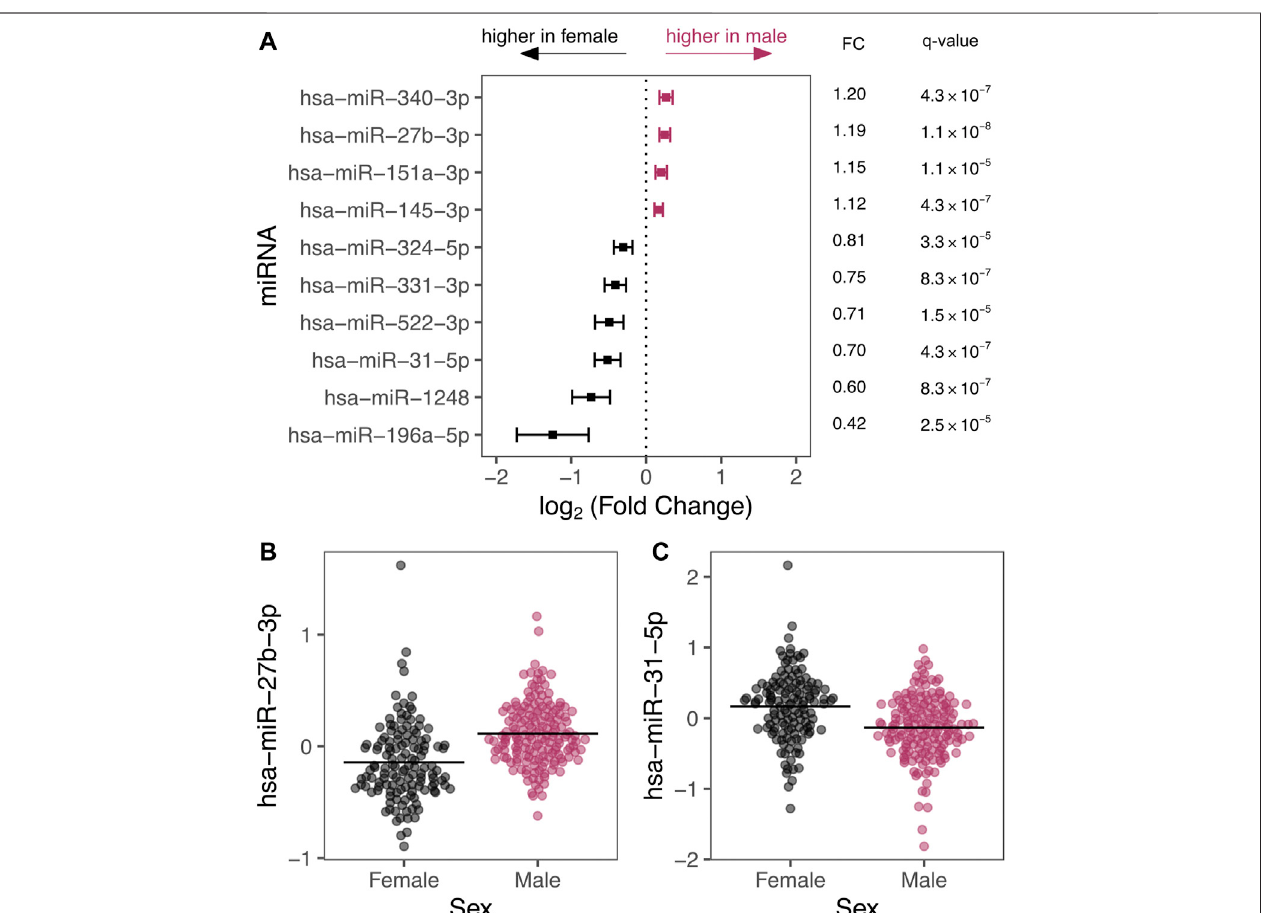
Frontiers in Genetics |